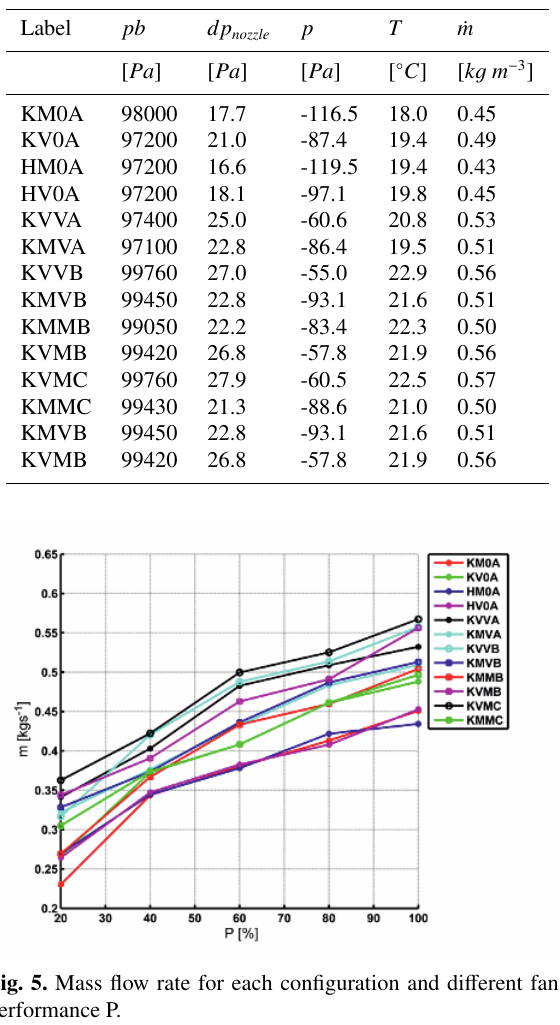
Table 1. Measured configurations with 100 % of fan performance